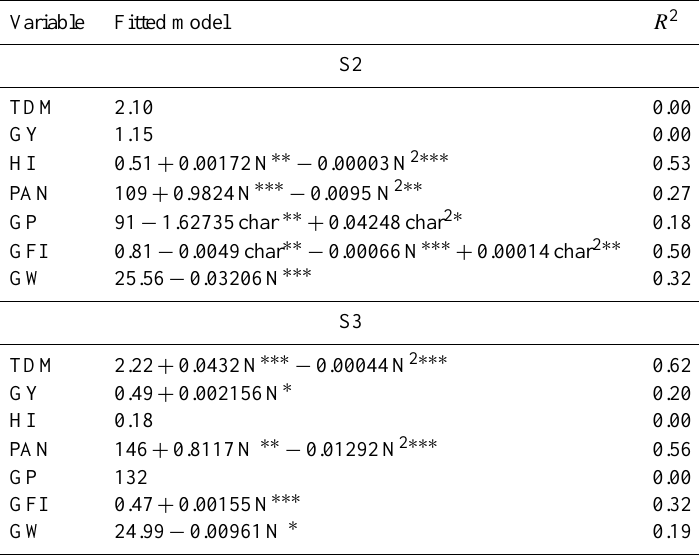
Table 3. Response surfaces representing the effect of biochar (char) and N-fertilisation (N) rates on total shoot dry matter (TDM, Mgha − 1 ) , grain yield (GY, Mgha − 1 ) , harvest index (HI) and yield components of aerobic rice at 2 (S2) and 3 (S3) years after application in a sandy Dystric